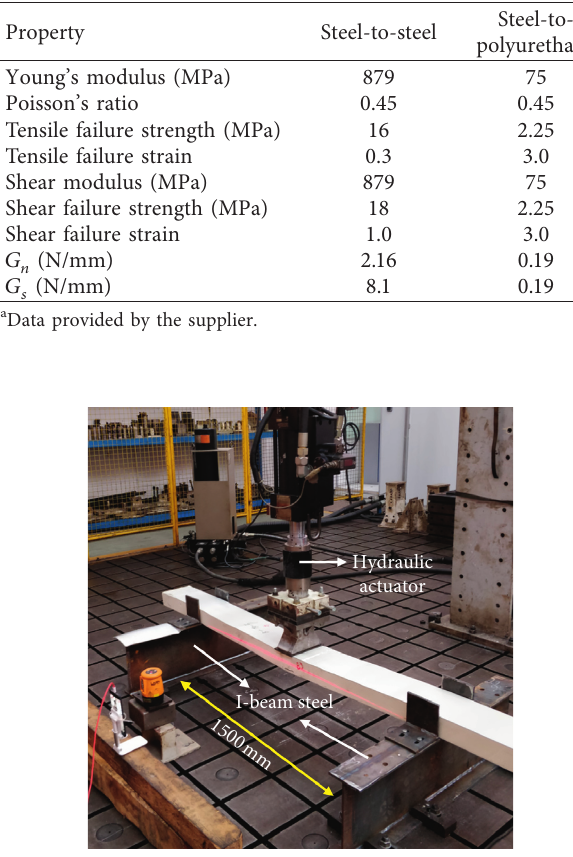
Figure 7: Setup of strength measurement of the adhesively bonded polyurethane-to-steel